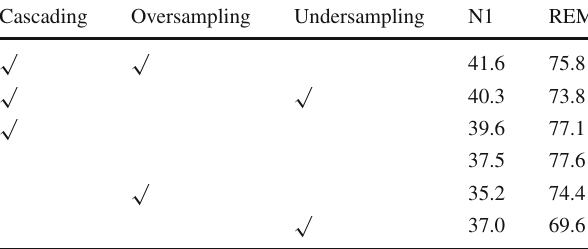
Table 5 The F1 results of part 2 ablation